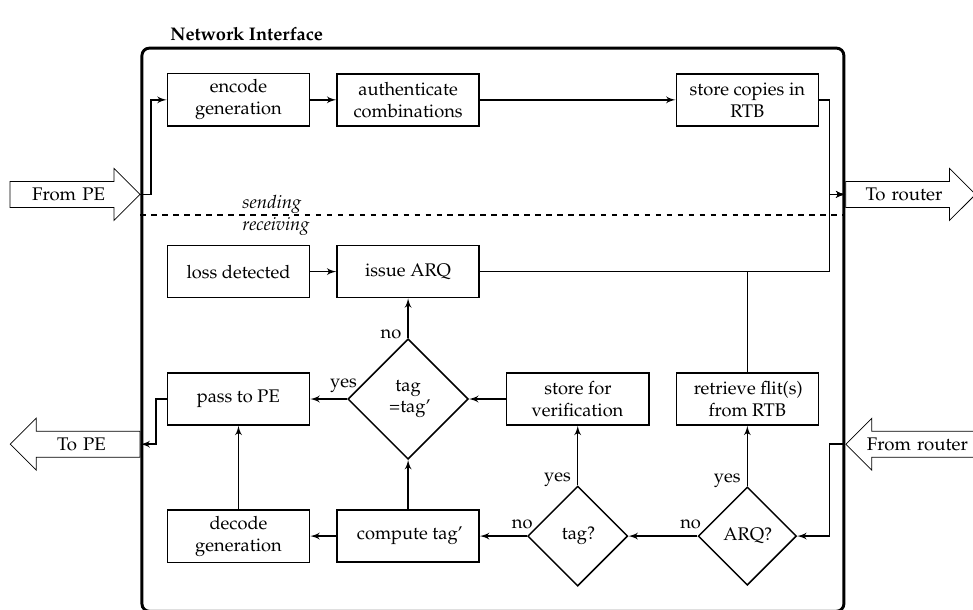
Figure 3. Steps performed by the network interface in case of S1/Network Coded (NC) transmission.